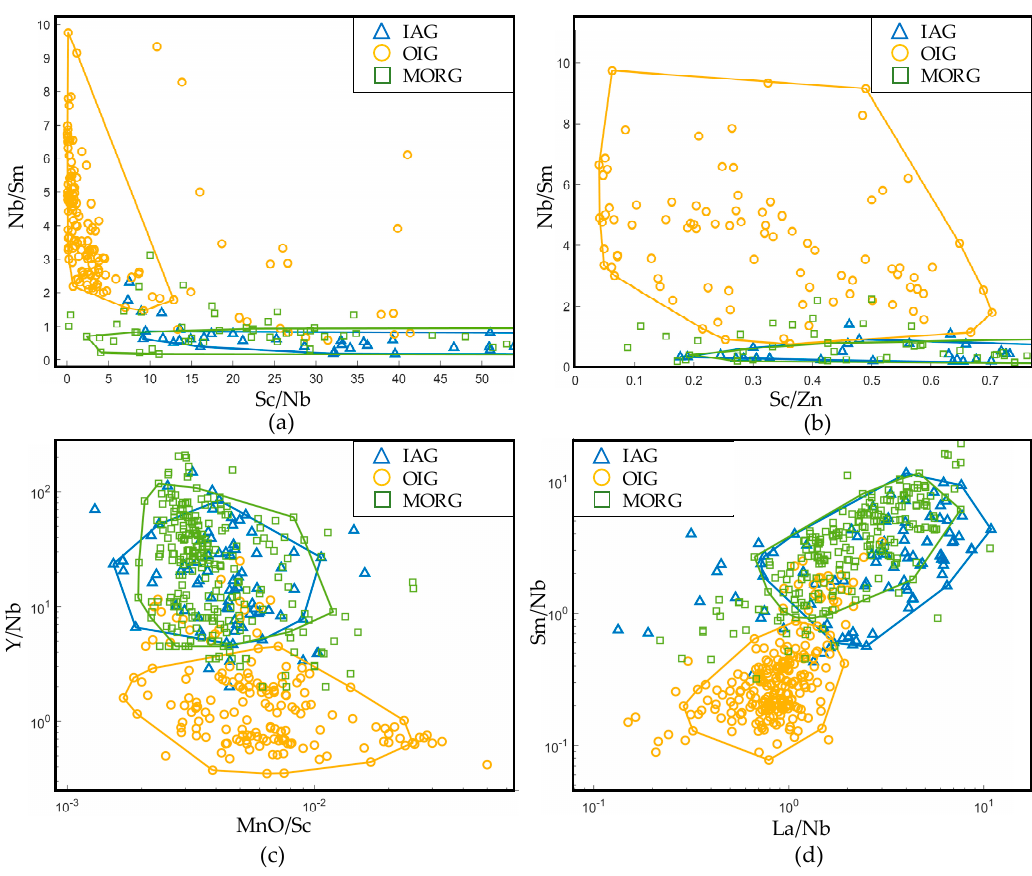
Figure 14. Discrimination diagrams for OIG and non-OIG. All four diagrams have a 0.85 confidence region. ( a , b ) are in linear coordinates; ( c , d ) are in logarithmic coordinates.